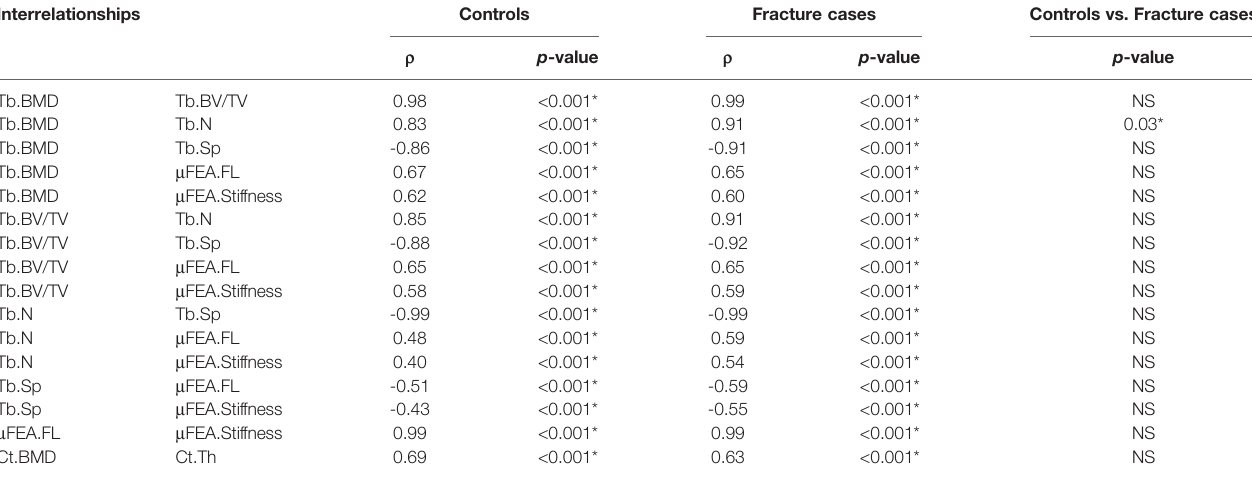
TABLE 3 | Global compartmental Spearman ’ s rank partial correlations for bone parameters assessed with the standard analysis method.